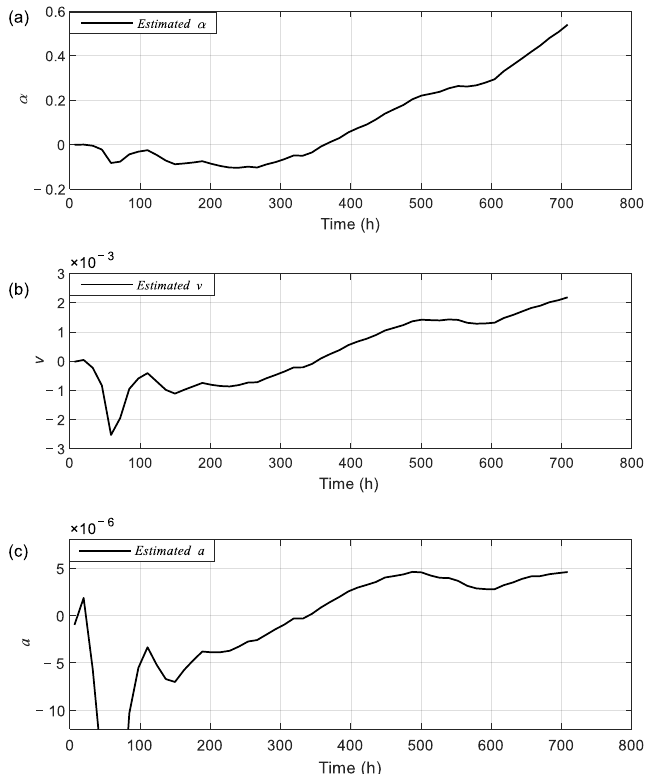
Figure 6. Degradation degree α ( a ), degradation speed v ( b ) and degradation acceleration a ( c ) esti- mation.